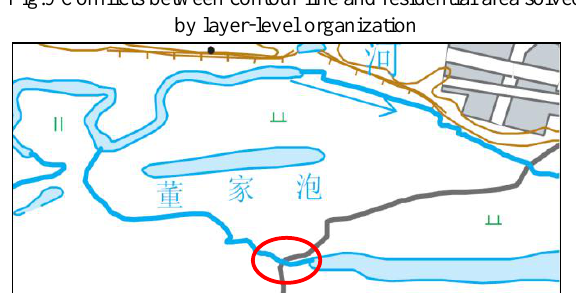
Fig.7 Initial user interface of a cartography project